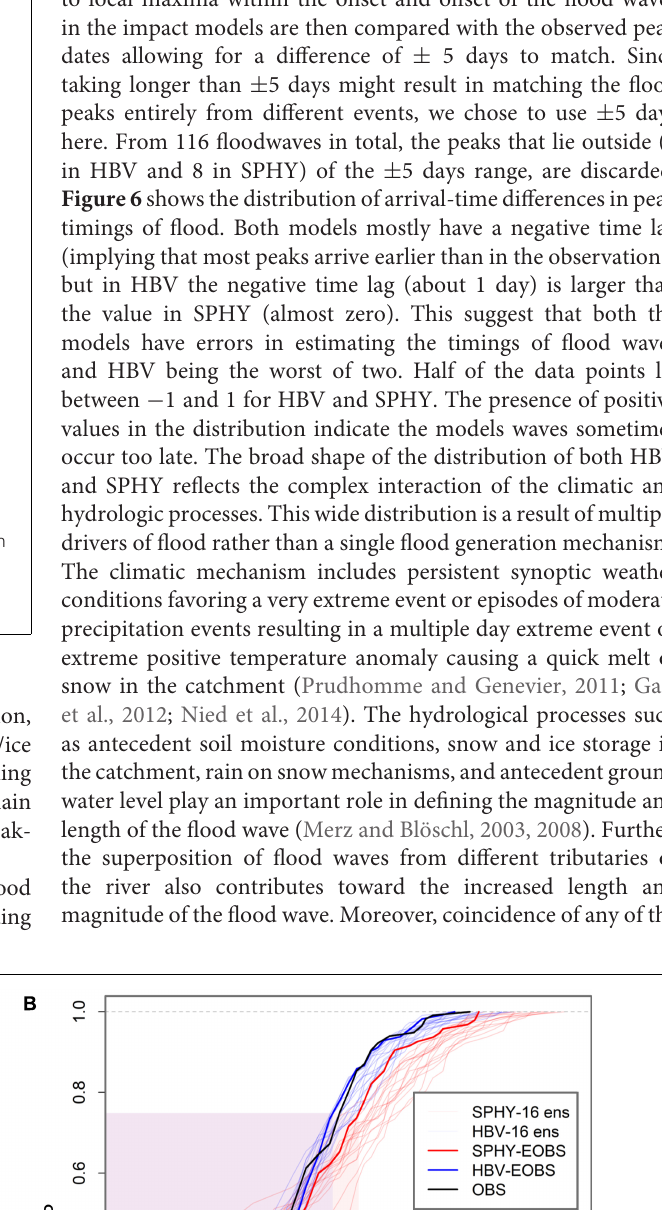
FIGURE 5 | (A) Frequency plot for the flood wave length above 95 th quantile threshold of discharge. The dash vertical lines show the mean of the flood waves for SPHY (red), HBV (black) and HBV (blue). (B) The Empirical cumulative distribution function (ECDF) plot for the floodwave length above 95 th quantile threshold of individual time series discharge. The light red and the blue shaded area represents the 0.25 and 0.75 for SPHY and HBV, respectively.